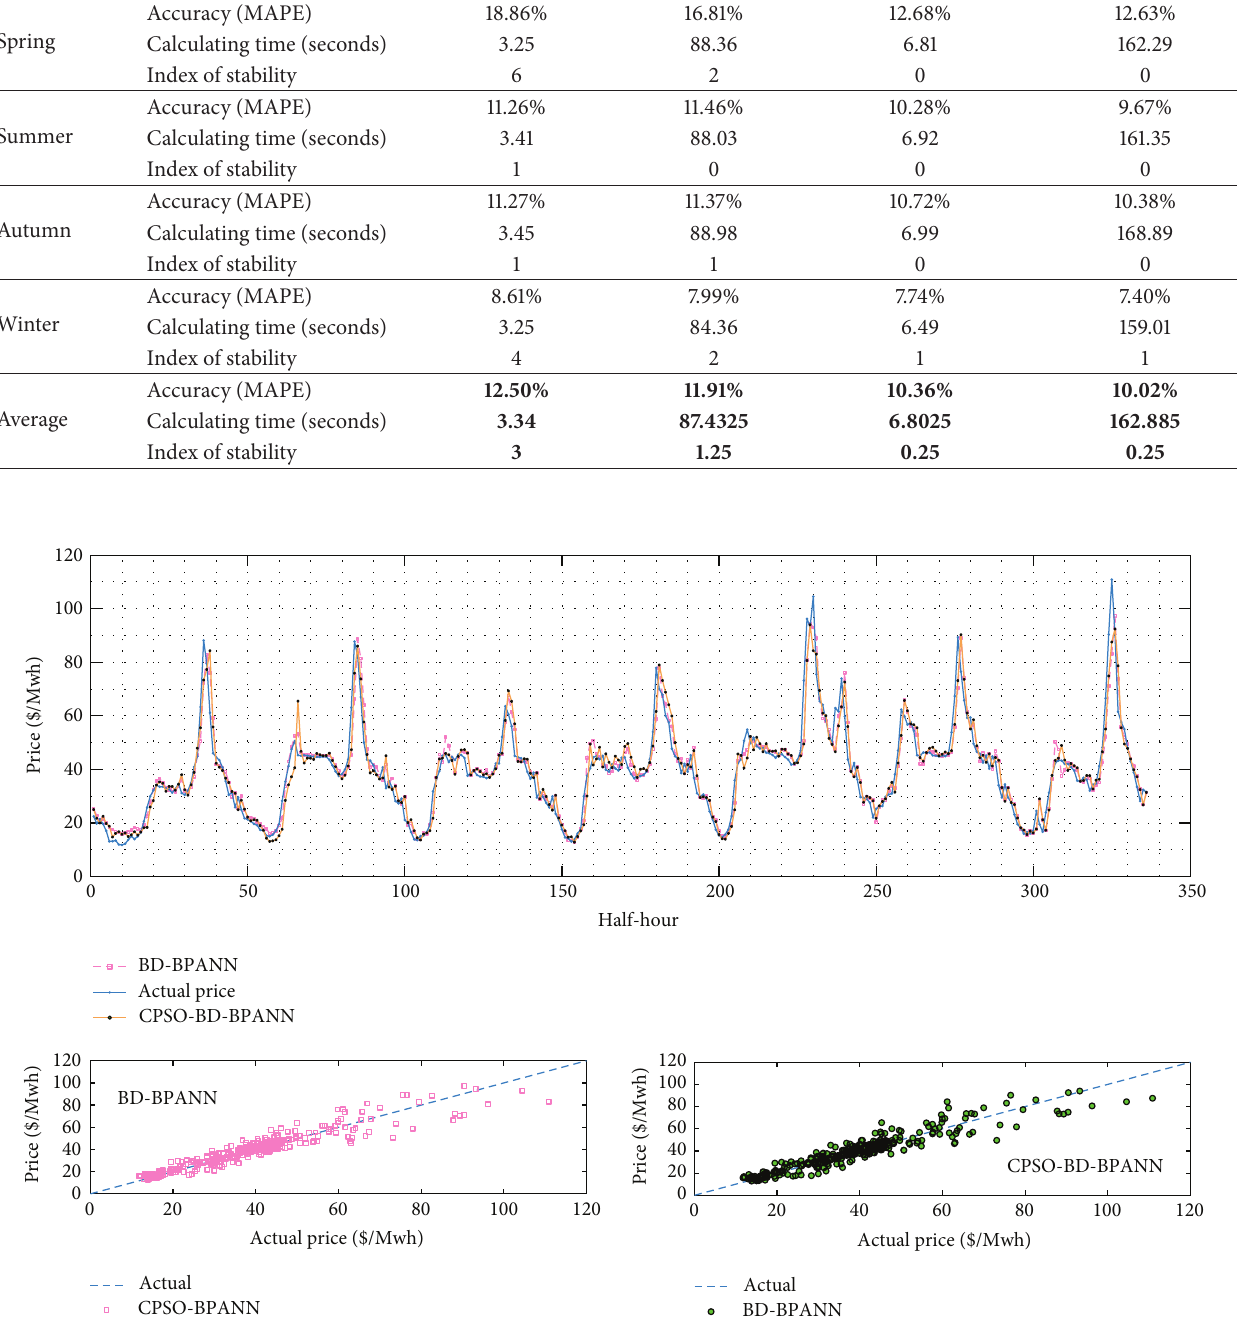
Figure 11: BD-BPANN and CPSO-BD-BPANN methods for case